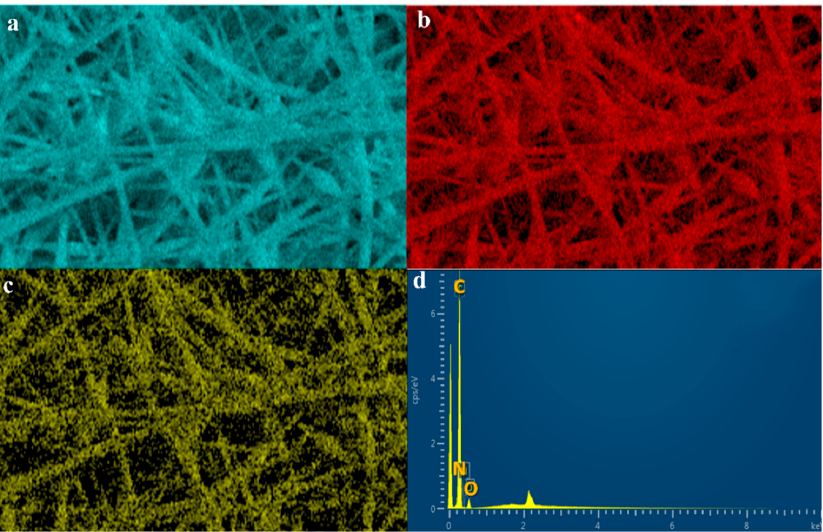
Figure 7. Energy Dispersive X ‐ ray Spectroscopy (EDX) map and spectra of ES ‐ SDIB/PBz ‐ 0 showing the elemental compositions: ( a ) carbon; ( b ) oxygen; ( c ) nitrogen and ( d ) spectra without sulfur (S) peak; (scale bar = 5 μ m); Other peaks without label in the spectra are Au used as coating material.